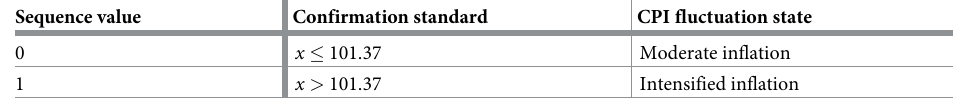
Table 8. A general criteria for CPI fluctuation states with two different types.